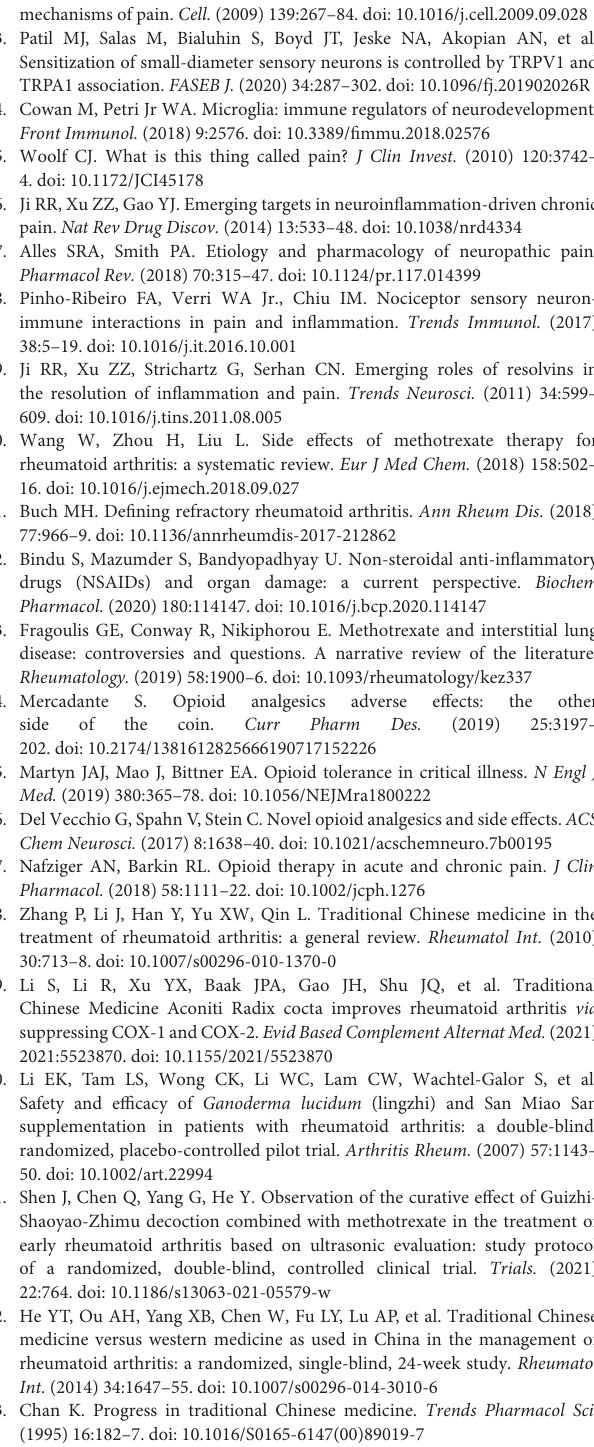
Supplementary Figure 1 | Changes in blood tests before and after TCM treatment. (a–d) : The Changes of ESR (a) , hsCRP (b) , RF (c) , and Anti-CCP Antibody (d) before and after TCM treatment,